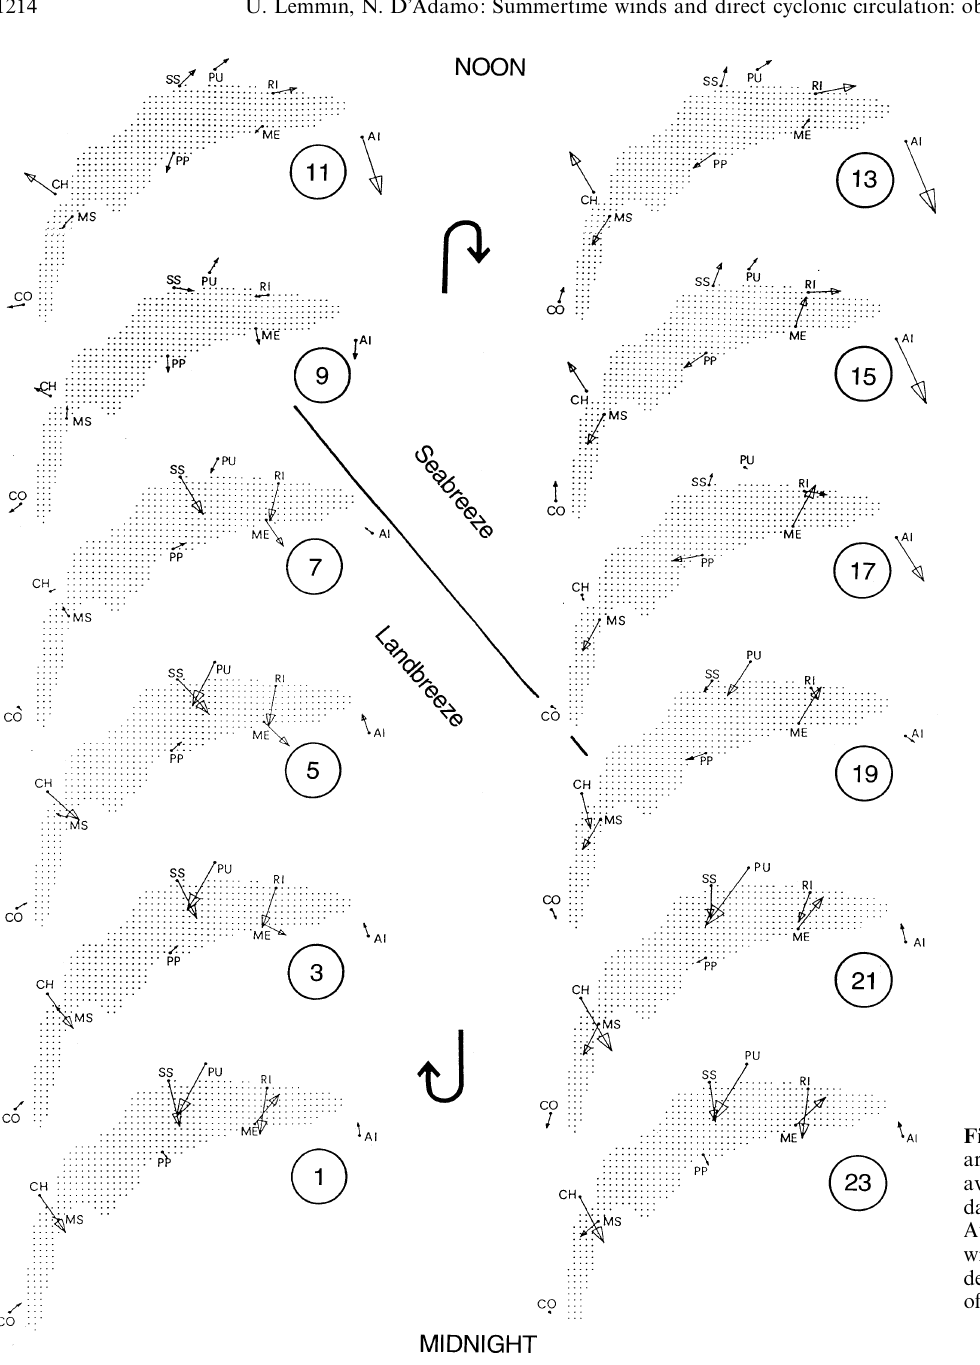
Fig. 6. A typical wind field around Lake Geneva. By averaging for each hour of the day over 45 days (from July to August 1986) 24 hourly mean wind vectors at all stations were derived. The corresponding hour of each diagram is